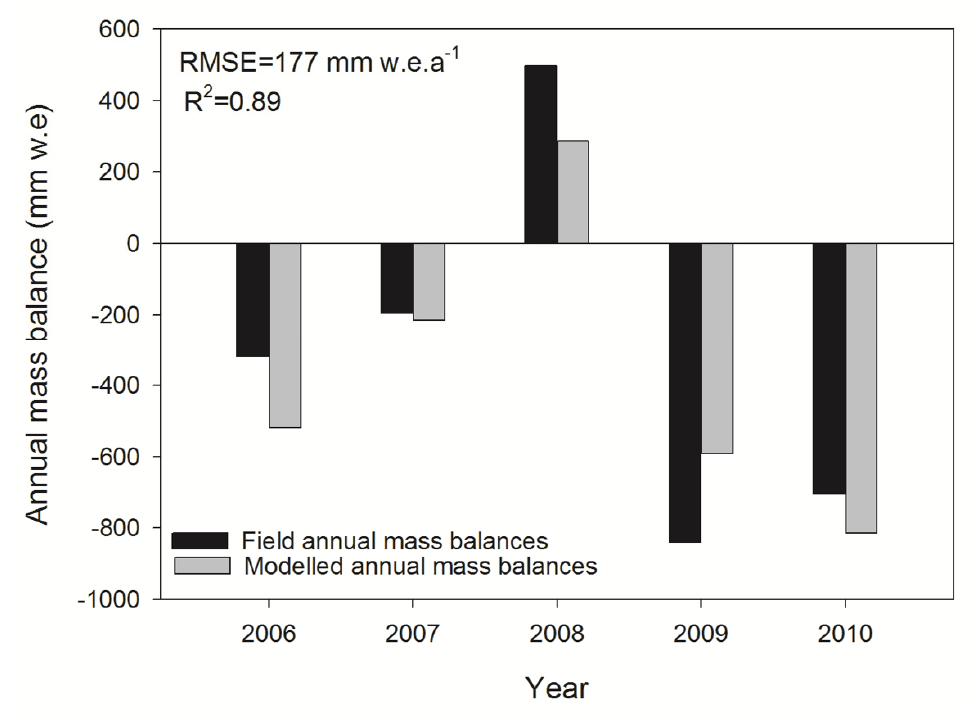
Figure 5. Comparison of modelled mass balances with observed mass balances for 2006–2010 in the Gurenhekou glacier.